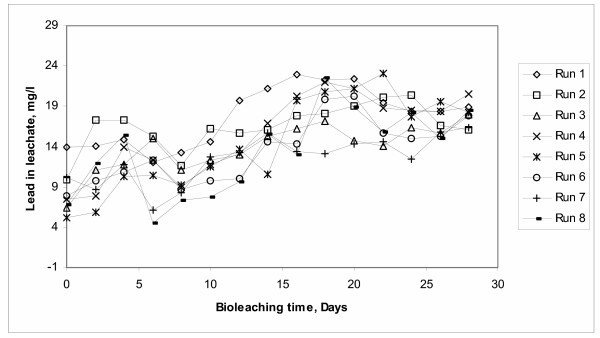
Lead Solubilized